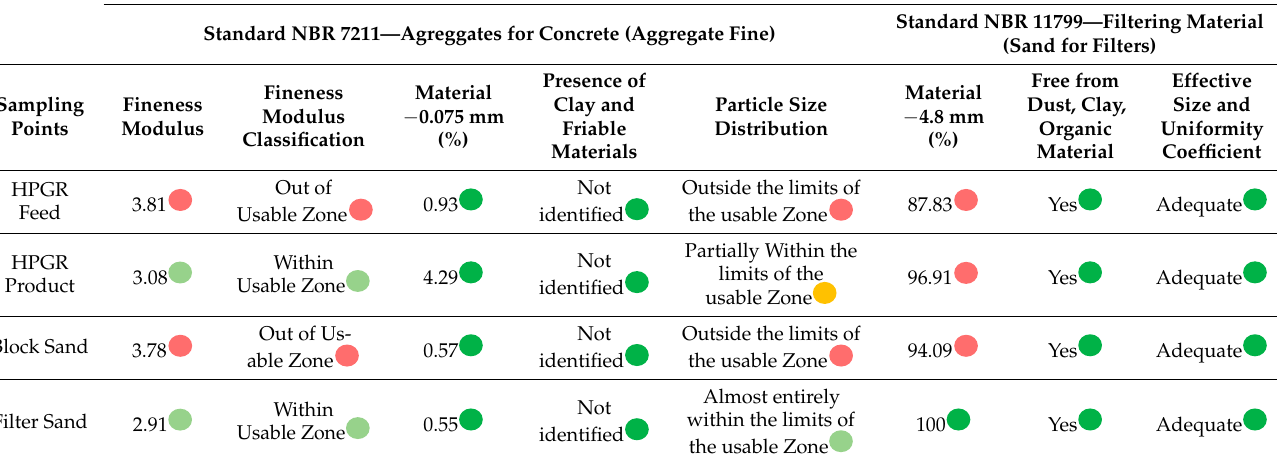
Table 8. Survey 1 product analysis.